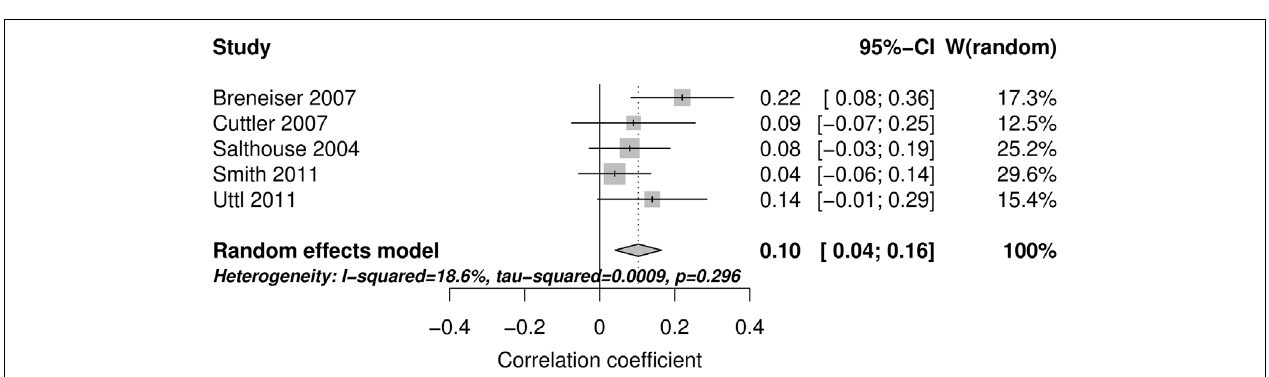
FIGURE 2 |The forest plot and random effect model meta-analysis for openness.